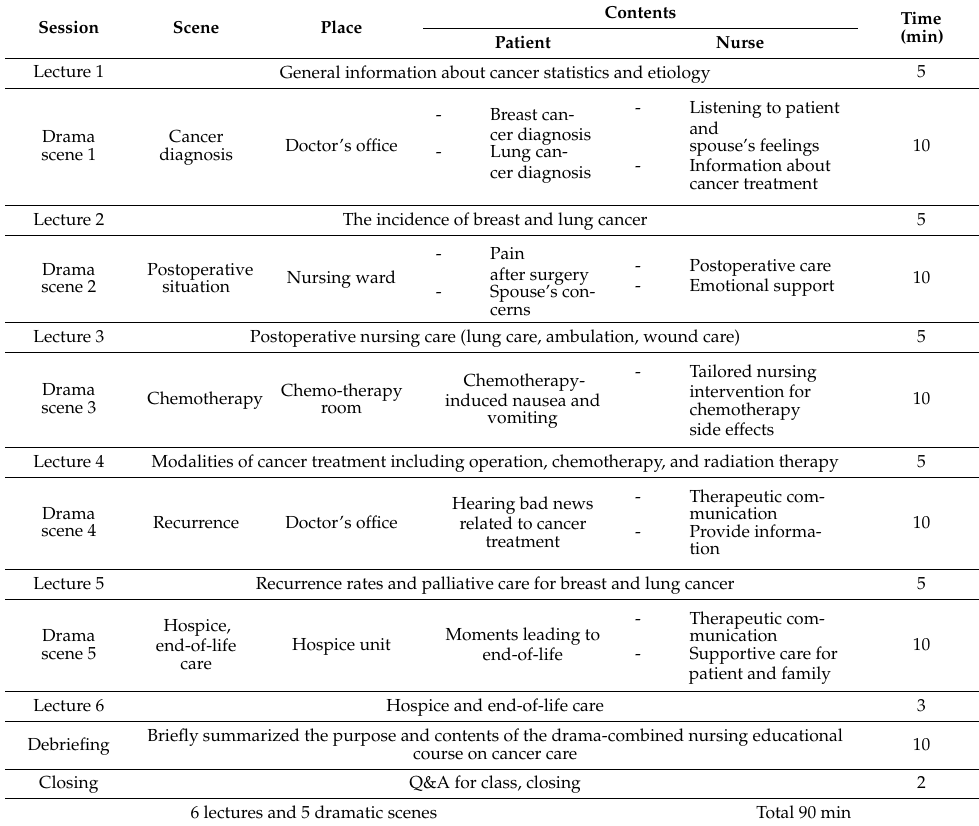
Table 1. Structure of drama-combined nursing education for cancer